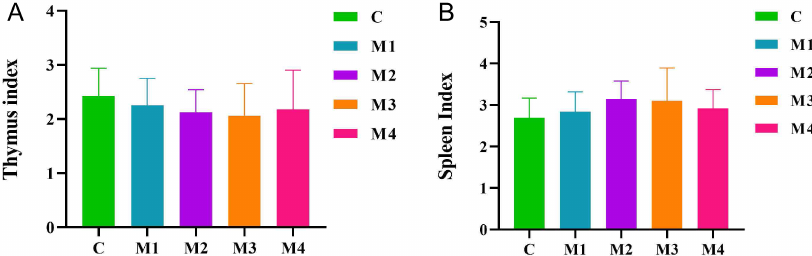
Figure 4. Effects of adenine combined with Folium sennae modeling on the viscera indexes of diarrhea mice. (A) Thymus index. (B) Spleen index. Data were expressed as mean ± standard deviation, n =